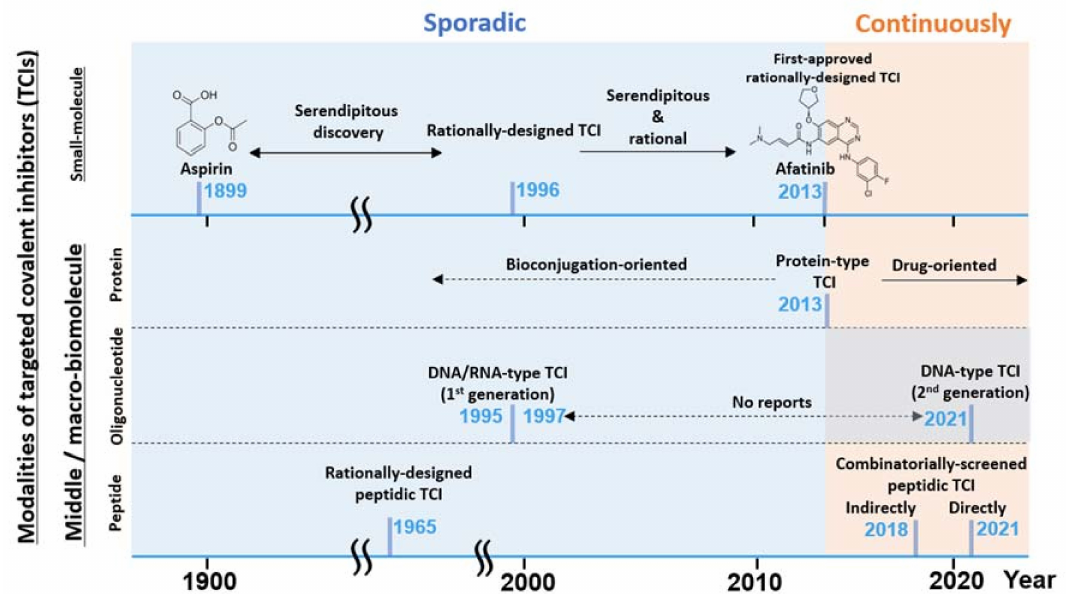
Figure 2. A graphical summary of the brief TCI history and recent hot topics described in this review. TCI modalities listed (left axis) vs. timeline (horizontal axis) and the notable development are listed. TCI development has been mostly sporadic until recently with the renewed interest [15] in TCI